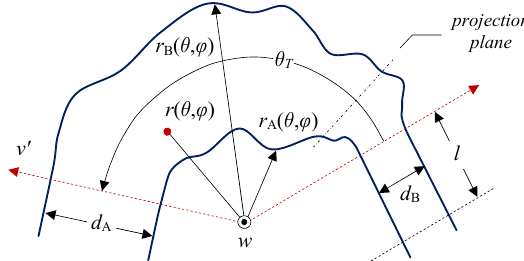
Figure 1: Transverse-plane view of a general discontinuity with constantly changing geometric